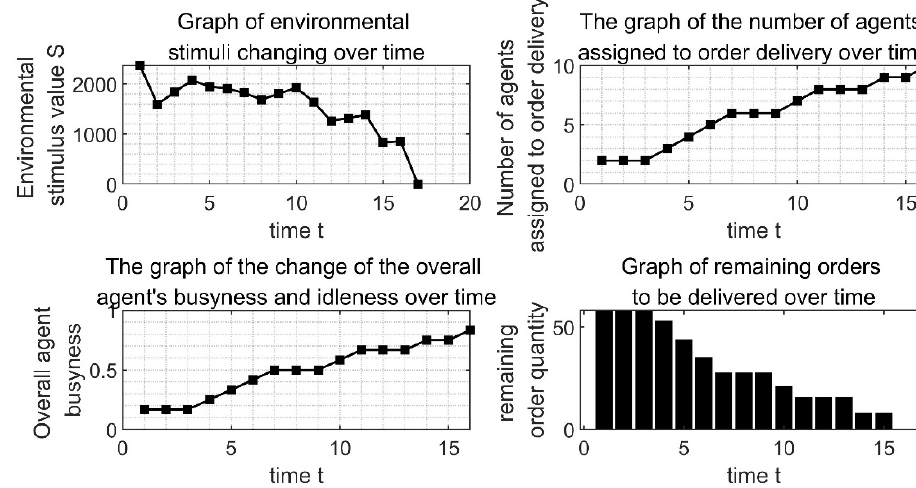
Figure 8. Change trend of key indicators during the allocation process.